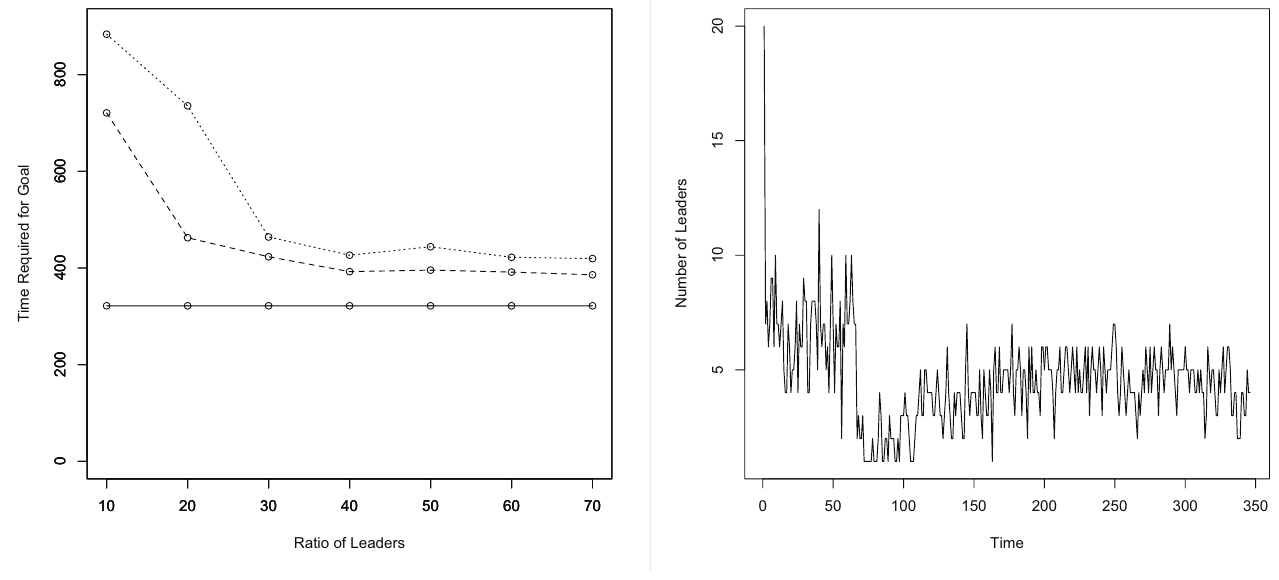
Figure 3: The time evolution of the number of lead- ers in